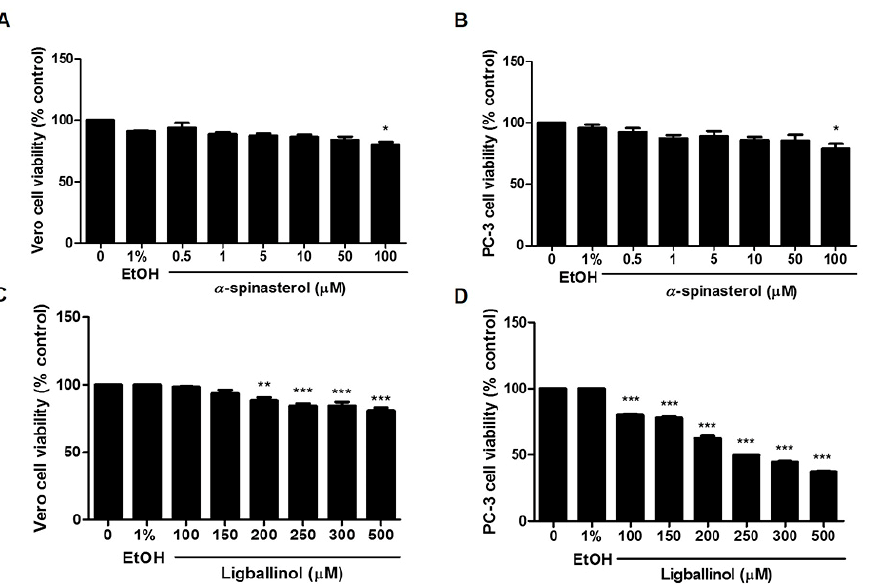
Figure 9. The antiproliferative effect of α -spinasterol and ligballinol on PC-3 and Vero cells. Cells were treated with various concentrations of ( A , B ) α -spinasterol and ( C , D ) ligballinol, and MTT assays were conducted. The results are expressed as means ± SEM. * indicates p < 0.05, ** indicates p < 0.01, and *** indicates p < 0.001: a significant difference versus control.